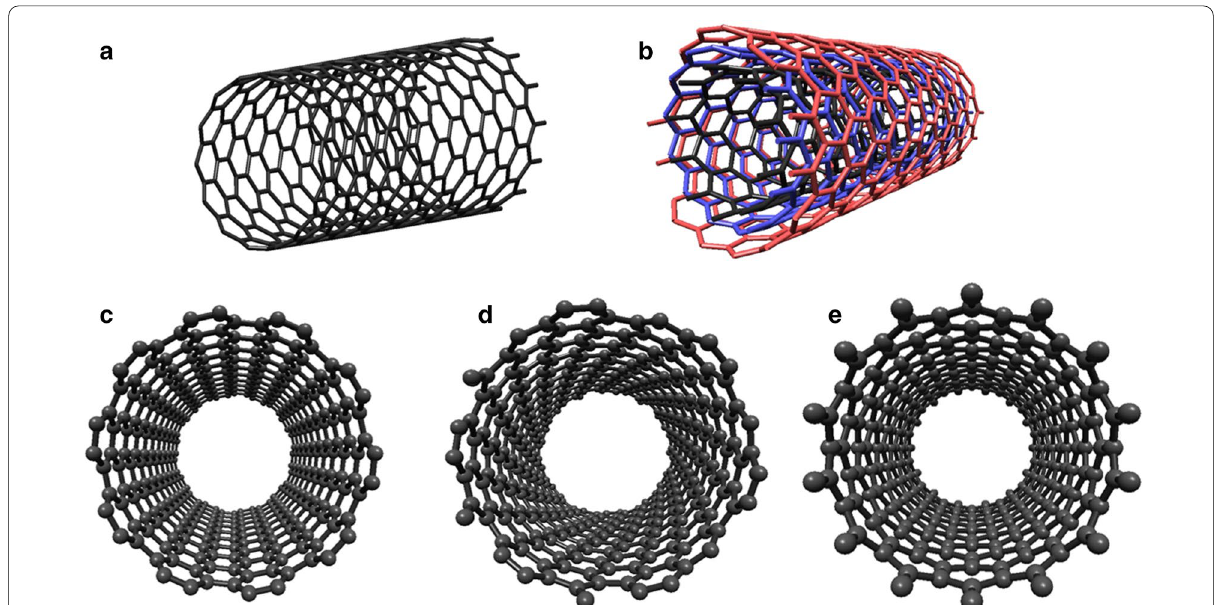
Fig. 6 The classification of the CNTs of a SWCNT, b MWCNT; Schematic representation of three typical types of SWCNTs c Armchair (10, 10), d Chiral (13, 6), and e Zigzag (14,